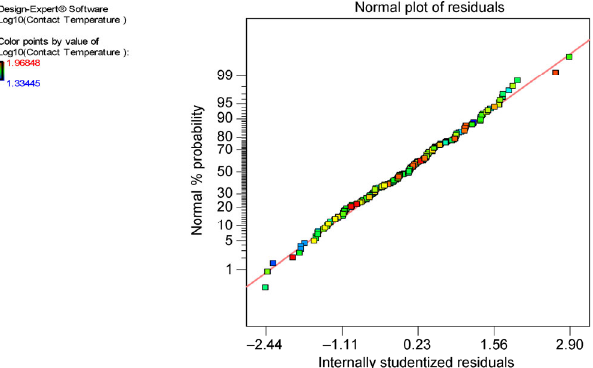
Fig. 15 Normal plot of residuals for maximum contact temperature.